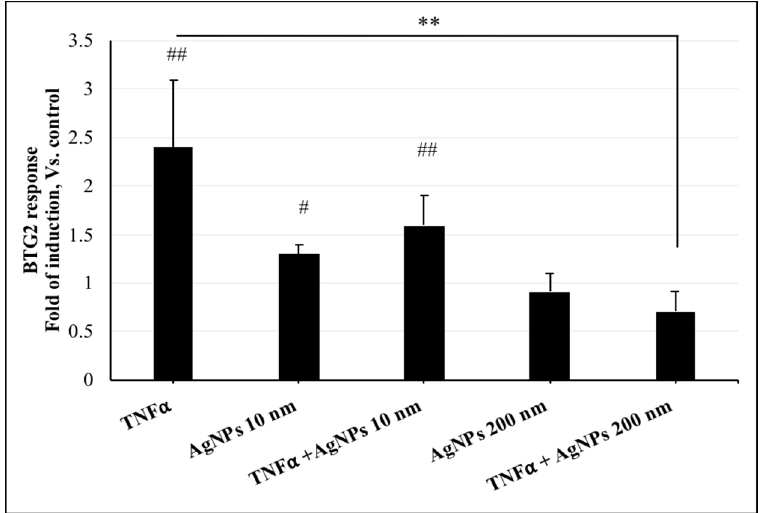
Figure 4. BTG2 response in NCI-H292 cells. Cells were transfected with BTG2 promoter-reporter plasmid, and then the transfected cells were exposed to TNF α (20 ng/mL) and AgNPs 10 nm (100 µ g/mL) or AgNPs 200 nm (100 µ g/mL) separately and together for 24 h. The results are shown as means ± SD, n ≥ 3, for each group; # indicates 0.01 < P < 0.05, ##, ** indicates P < 0.01. # represents a significant increase compared to the control group. * represents a significant decrease compared to the TNF α -exposed group.